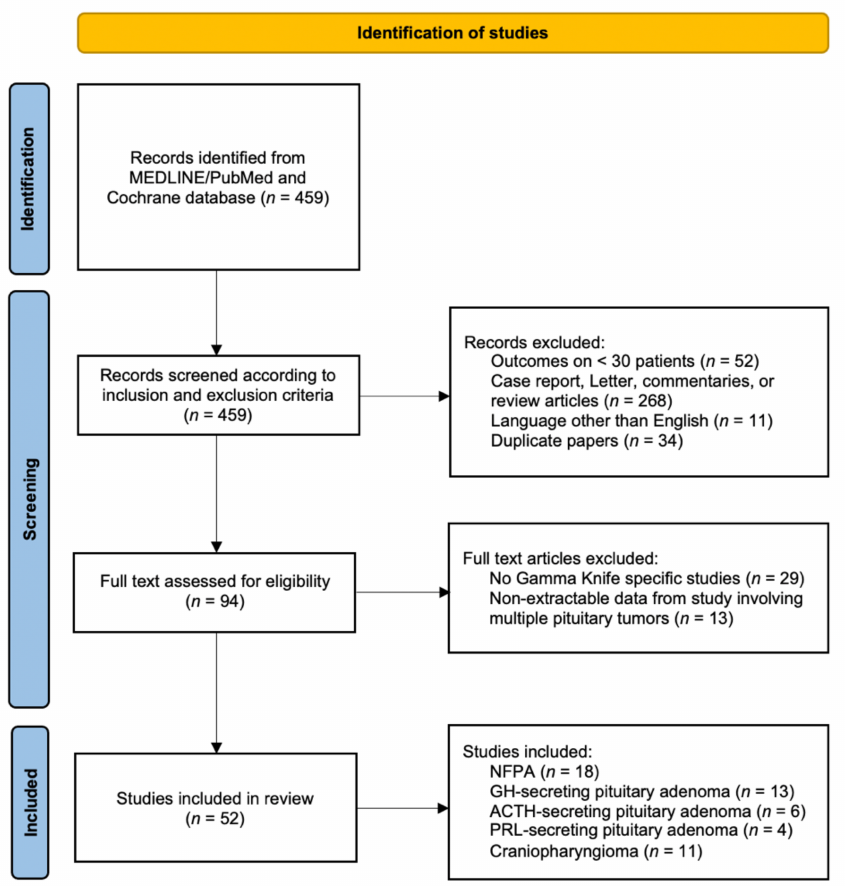
Figure 1. PRISMA Flowchart of study selection. Abbreviations: ACTH = adrenocorticotropic hormone; GH = growth hormone; NFPA = non-functioning pituitary adenomas; PRL = prolactin